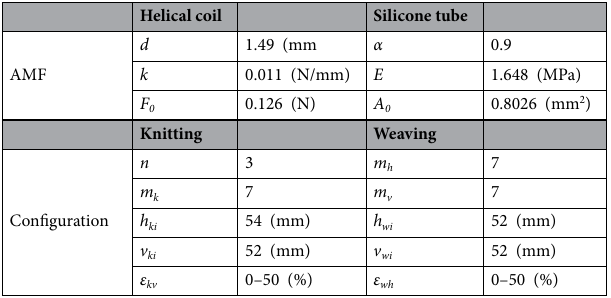
Table 1. Parameters of analytical models. k and F 0 at length 50 mm, E at 100%